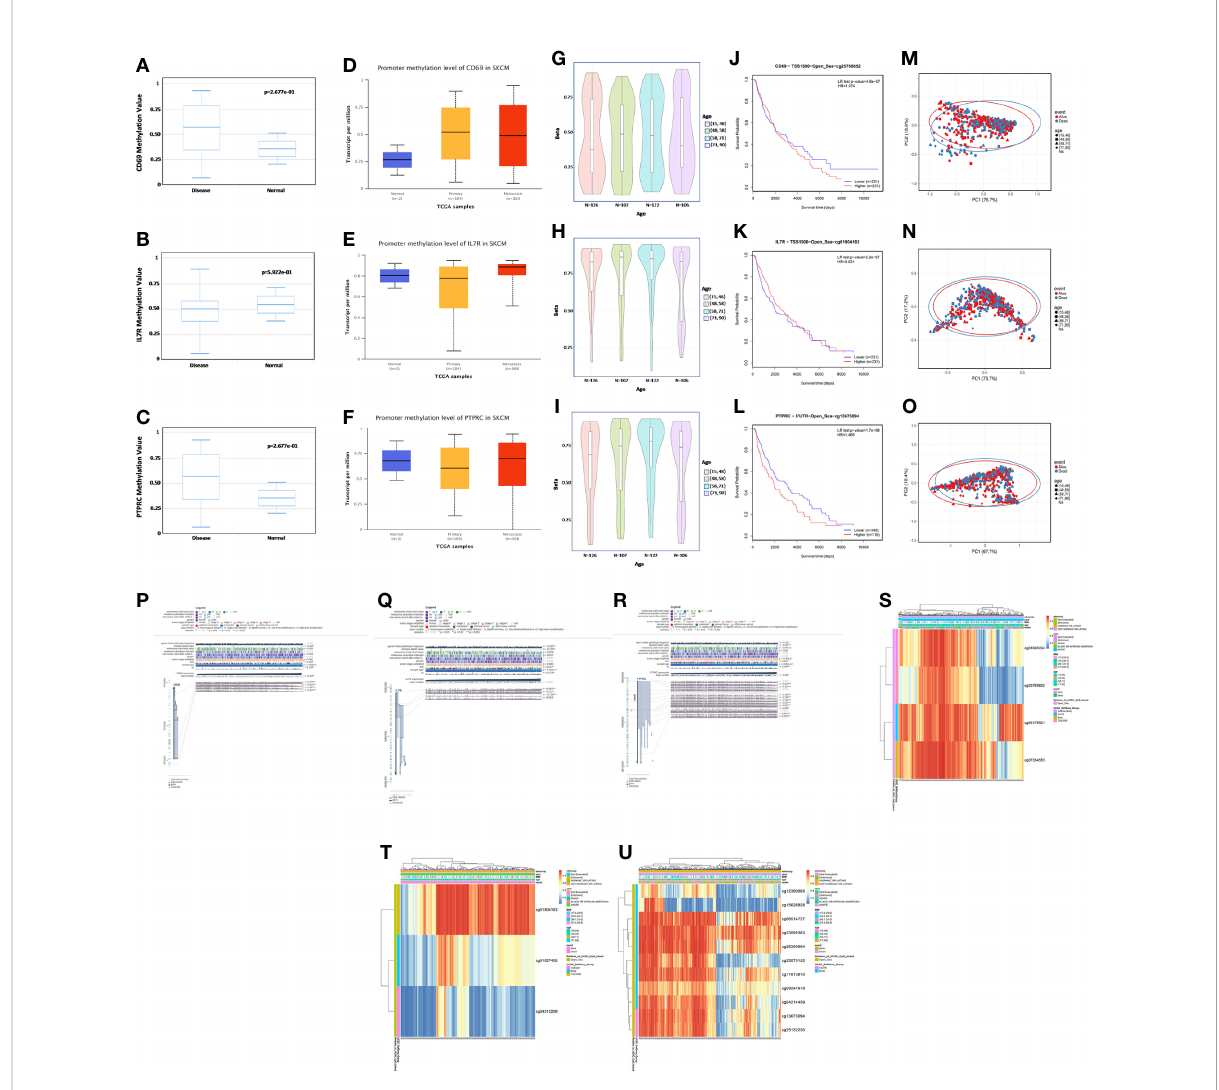
FIGURE 8 Methylation analysis of CD69 , IL7R , and PTPRC. (A – C) Methylation levels of CD69 , IL7R , and PTPRC in normal and disease datasets assessed using DiseaseMeth (version 2.0). (D – F) Promoter methylation level of CD69 , IL7R , and PTPRC in normal skin, primary SKCM, and metastasis datasets evaluated using UALCAN. (G – I) Methylation level of CD69 , IL7R , and PTPRC in normal tissues of people with different ages. (J – L) Correlation between CD69 , IL7R , and PTPRC methylation levels and the survival curve of SKCM patients. (M – O) In the three genes, differences between the proportion of PC1 and PC2 is high, showing that the level of methylation has a signi fi cant association with survival outcomes of SKCM patients. (P – R) Methylation sites of CD69, IL7R, and PTPRC and their expression levels as visualized using MEXPRESS. The expression of CD69 , IL7R , and PTPRC is illustrated by the blue line in the center of the plot. Pearson ’ s correlation coef fi cients and p-values for methylation sites and query gene expression are shown on the right side. (S – U) Heatmap of the expression of different methylation sites in CD69 , IL7R , and PTPRC in different samples; the ethnicity, race, body mass index, age, event, and other variables are indicated, and the whole analysis was carried using the MethSurv